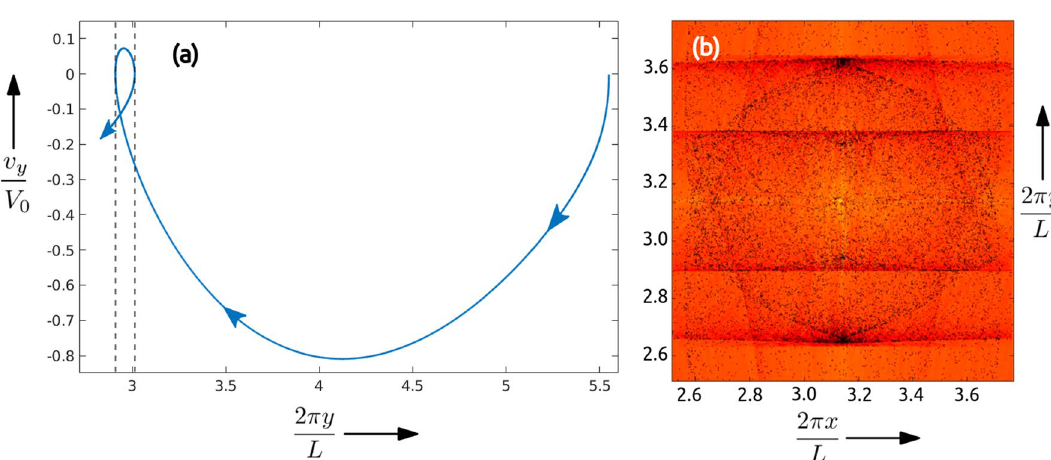
Figure 3. (a) The particle trajectory in the reduced phase space, ( y , v y ) , shows the multi-valued nature of the casutics in velocity between the dotted vertical lines 32 . The movie in C.2 shows the evolution of the bi-disperse particles overlaid on the corresponding DMD from Fig. 2b and the plot (b) shows a snap-shot at the 650th iteration step when the caustics and the DMD wavefronts coincide. Notice that the first DMD picks out only the slow moving horizontal caustics. The plot and the figure was generated using Matlab 2020a, https:// www. mathw orks. com/ produ cts/ matlab.